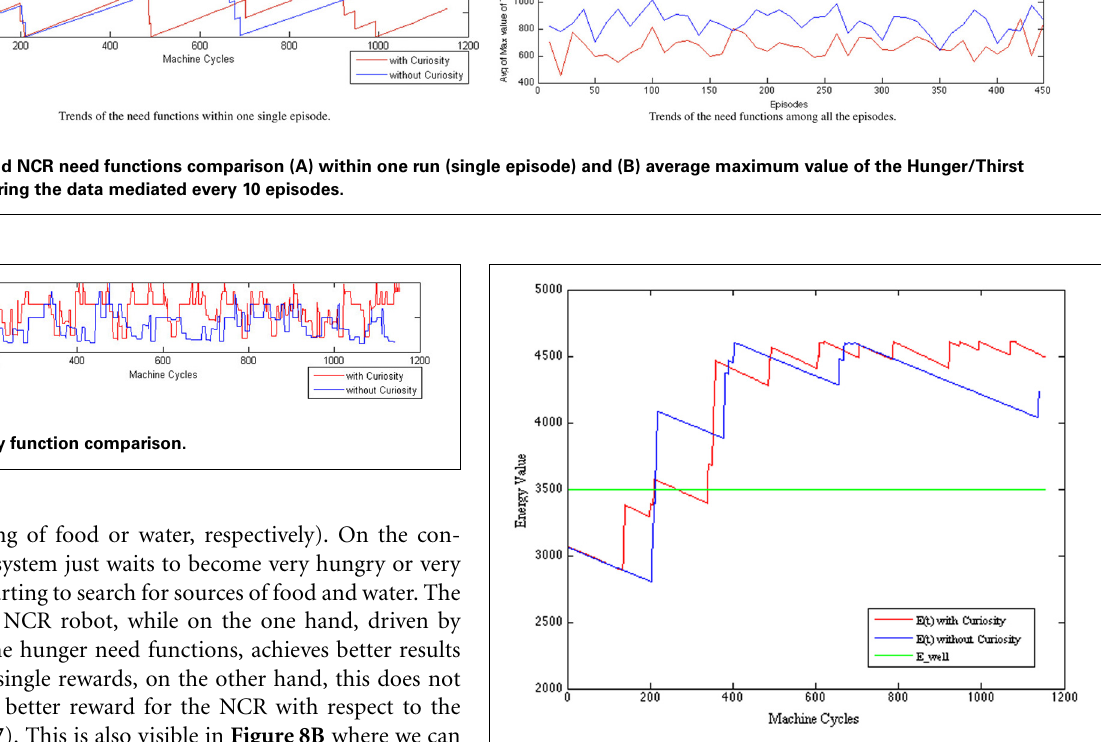
FIGURE 10 | Energy function